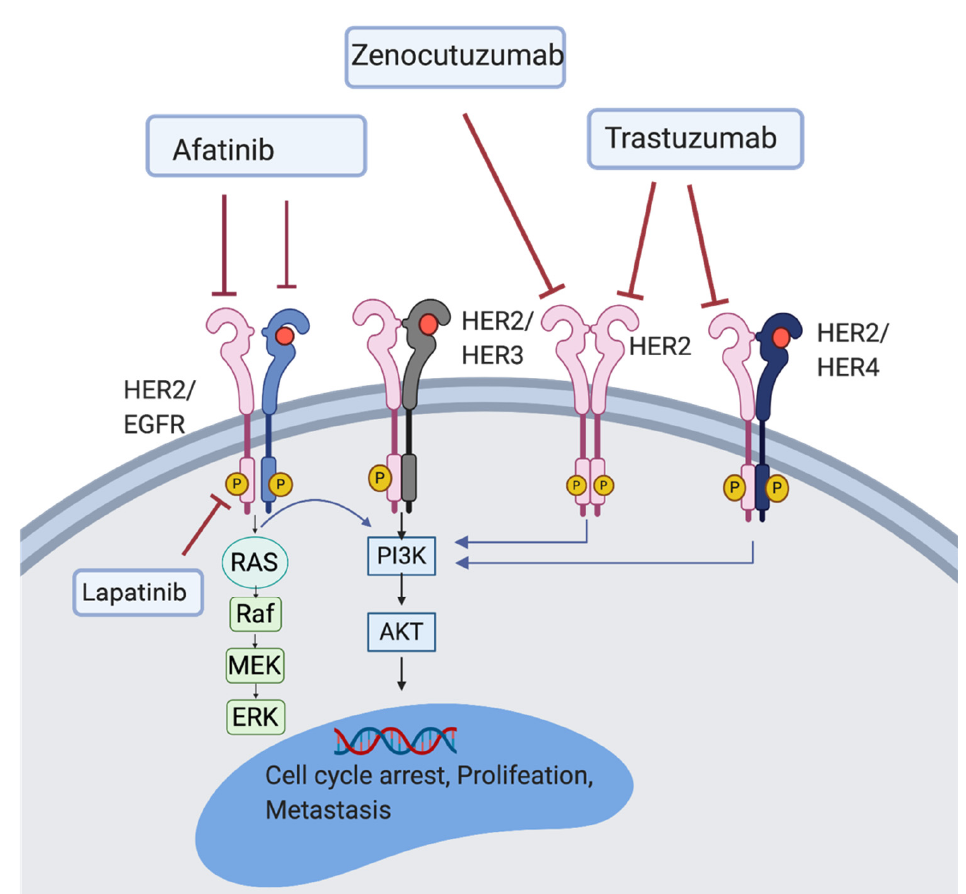
Figure 1. Illustration of the HER2 signalling pathway. HER2 inhibitor (trastuzumab); HER2/EGFR inhibitors (lapatinib and afatinib); HER2/HER3 inhibitor (zenocutuzumab).